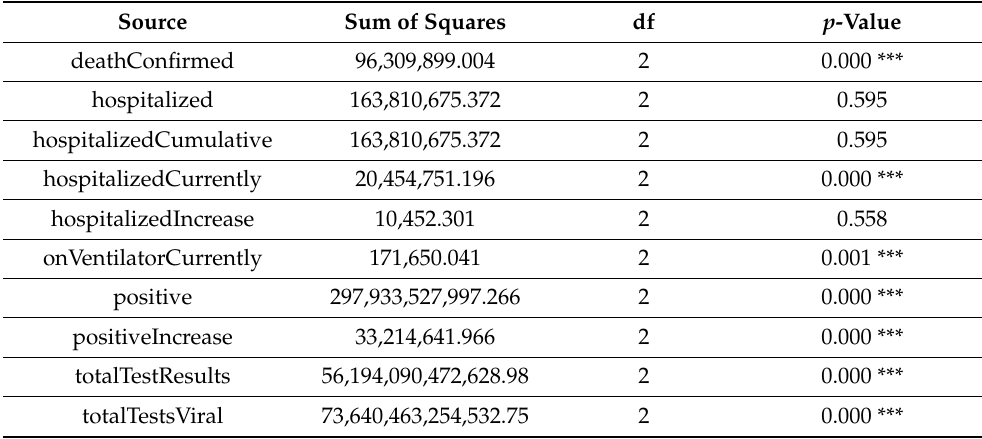
Table 8. ANOVA analysis results with K-means